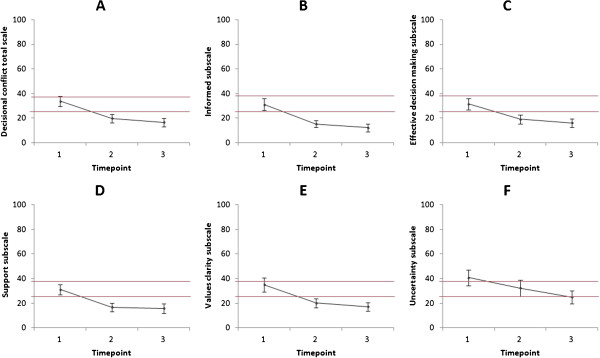
Trends relating to decisional conflict overall scale and five subscales about using one’s personal genome in an advanced genome sequencing course. These were observed as part of a two-part genomics course taken by 19 students at the Icahn School of Medicine at Mount Sinai in 2012. All P values were calculated using paired samples t-tests. Lower scores indicate lower levels of decisional conflict. Scores are means with standard error bars displayed. (A) Decisional conflict about whether or not to get one’s own genome sequenced decreased over time between T1 and T2 (P < 0.001) and T1 and T3 (P < 0.001). The difference was not significant between T2 and T3 (P = 0.10). (B) Scores on the informed subscale decreased between T1 and T2 (P = 0.002) and between T1 and T3 (P < 0.001) indicating students felt more informed at T2 and T3 than they did at T1. (C) Scores on the effective decision-making subscale decreased between T1 and T2 (P = 0.001) and between T1 and T3 (P = 0.001), indicating students felt more satisfied with their decisions at T2 and T3 than they did at T1. (D) Scores on the support subscale decreased between T1 and T2 (P = 0.003) and between T1 and T3 (P = 0.003), indicating students felt more supported at T2 and T3 than they did at T1. (E) Scores on the values clarity subscale decreased between T1 and T2 (P = 0.012) and between T1 and T3 (P = 0.005), indicating students felt greater clarity about their values at T2 and T3 than they did at T1. (F) Scores on the uncertainty subscale decreased between T1 and T3 (P = 0.006), indicating students felt less uncertainty about their decisions at T3 than they did at T1.